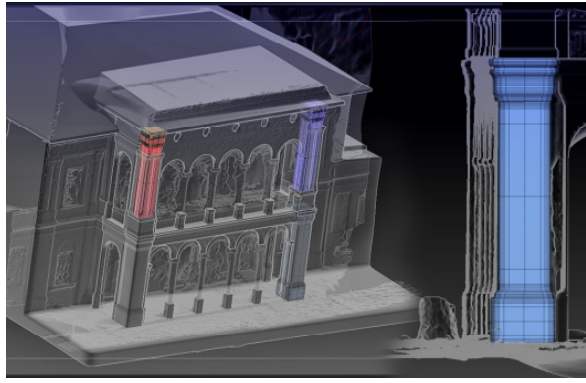
Figure 10. Polygonal model obtained from cloud computing in